Question: How would you classify this visualization?
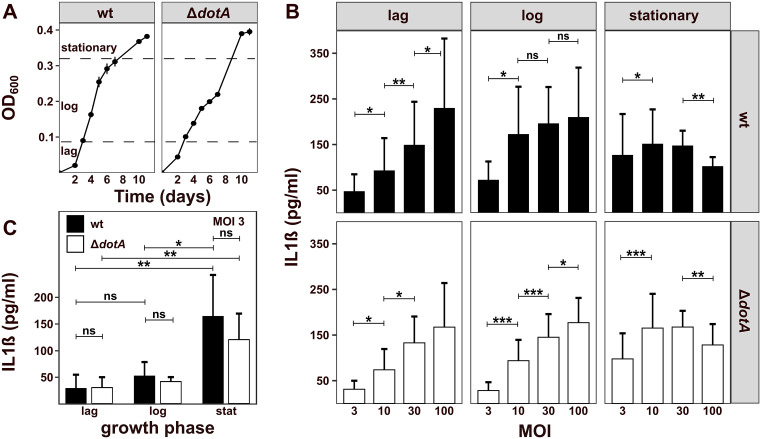
Answer: line